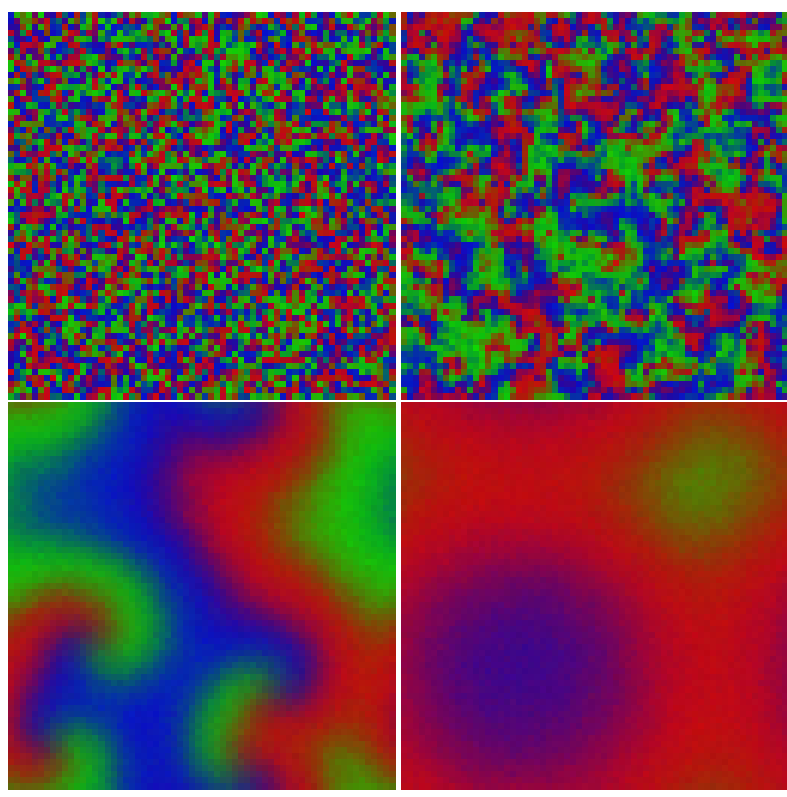
Figure 4. Typical snapshots of stochastic simulations of the model with ( β , σ , ζ , µ ) = ( 1,1,0.6,0.01 ) , N = 1024 and L = 64 and different mobility rates after a time t = 200. The mobility rate and predicted wavelength are from left to right: ( δ , λ ) = ( 0.000625,1 ) and ( δ , λ ) = ( 0.005625,3 ) in the top row, and ( δ , λ ) = ( 0.64, L /2 ) and ( δ , λ ) = ( 1.44,3 L /4 ) in the bottom row, see text. Adapted from [47].